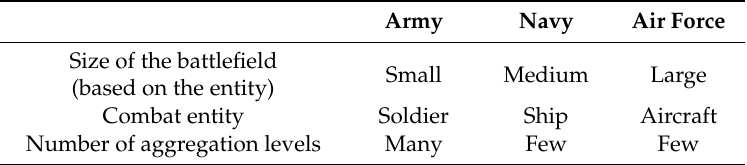
Table 3. The di ff erences in characteristics of each